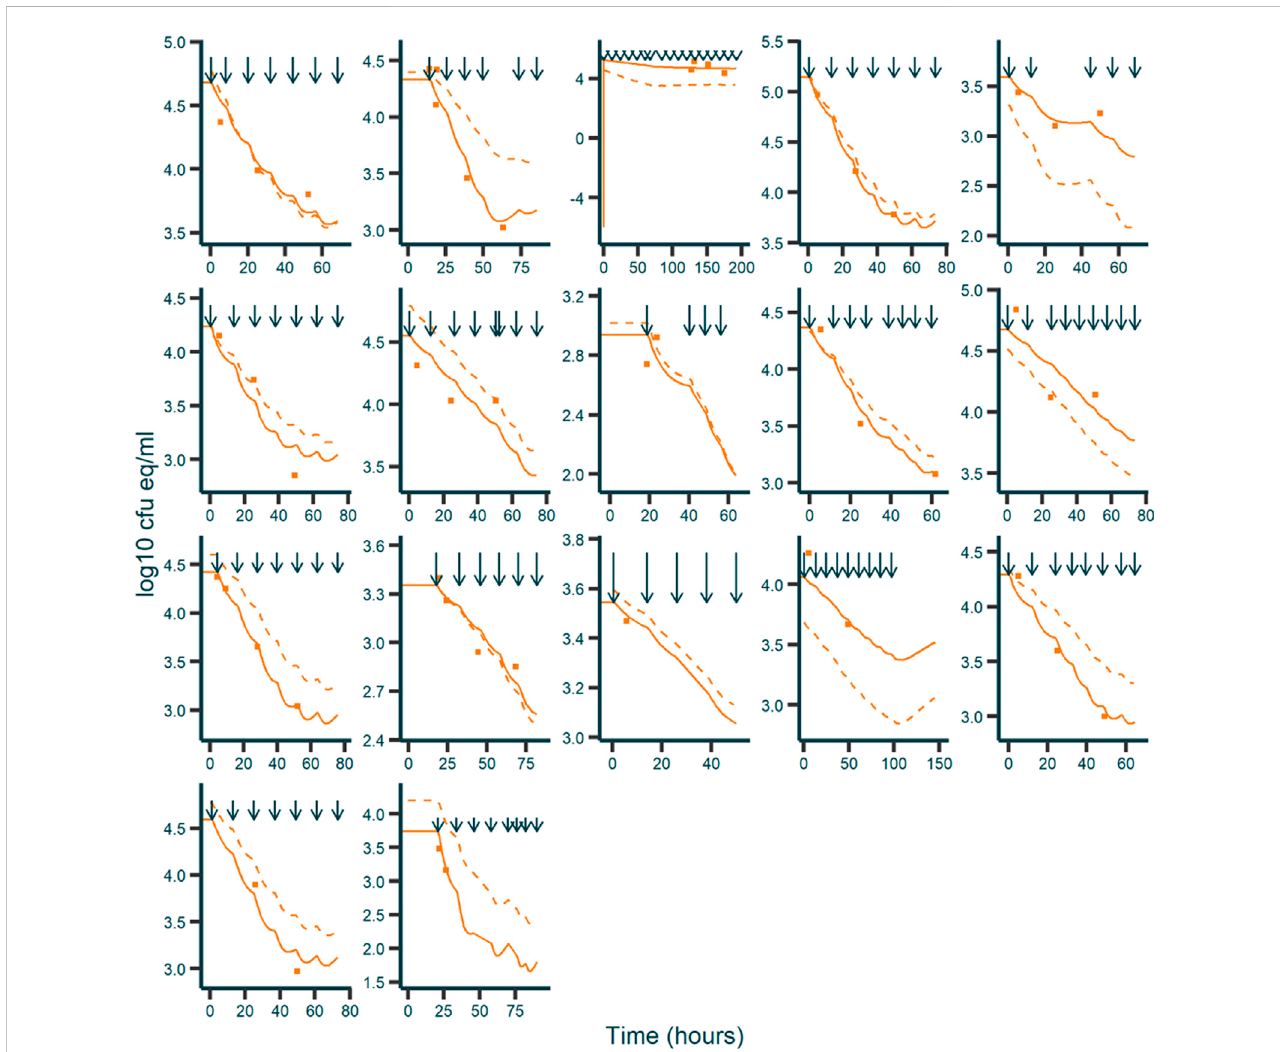
FIGURE 4 Fittedand observedBDL overtimeforindividualresponders. X -axis:timeinhours. Y -axis:BDL inlog10 cfueq/mL.Darkbluearrows:vancomycindosing times. Orange squares: observations. Solid orange line: individual predictions. Dashed orange line: population predictions.